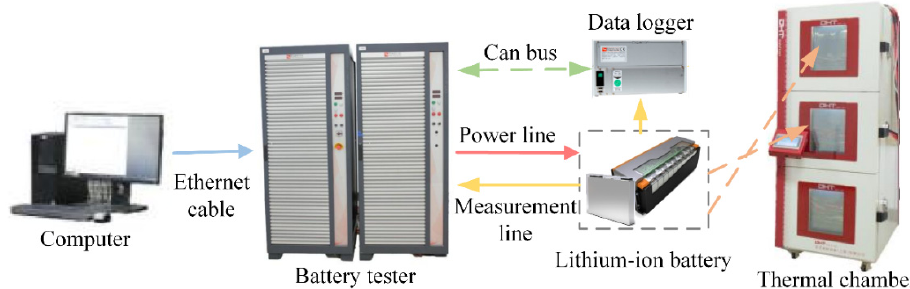
Figure 7. The platform for the battery aging experiment.